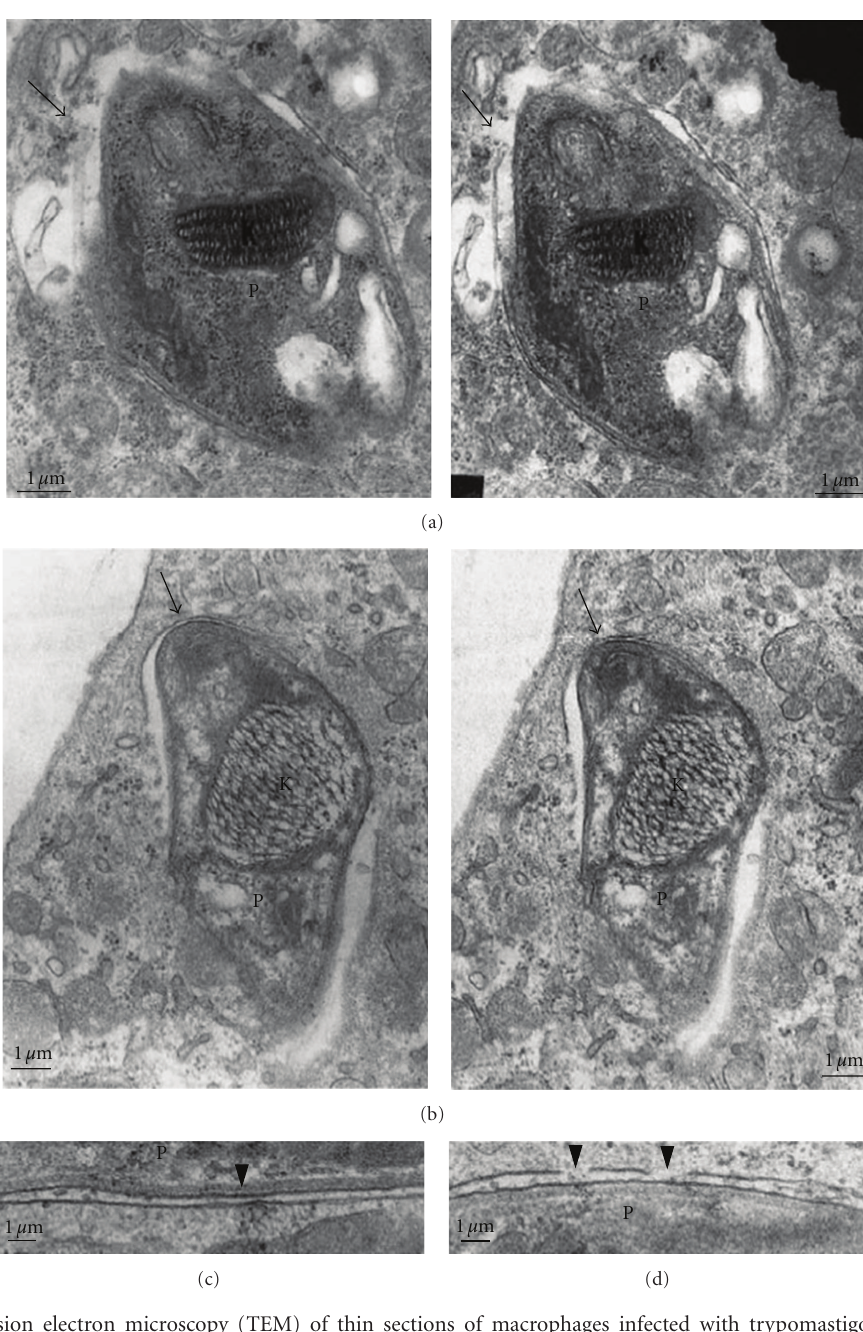
Figure 9: Transmission electron microscopy (TEM) of thin sections of macrophages infected with trypomastigote forms of T. cruzi . Micrographs taken at di ff erent inclination angles of the section. Focal disruption of the membrane lining the vacuole is observed (arrows in (a) and (b)) and especially in (c) and (d); K = kinetoplast, P = parasite. Bars = 1 μ m (after